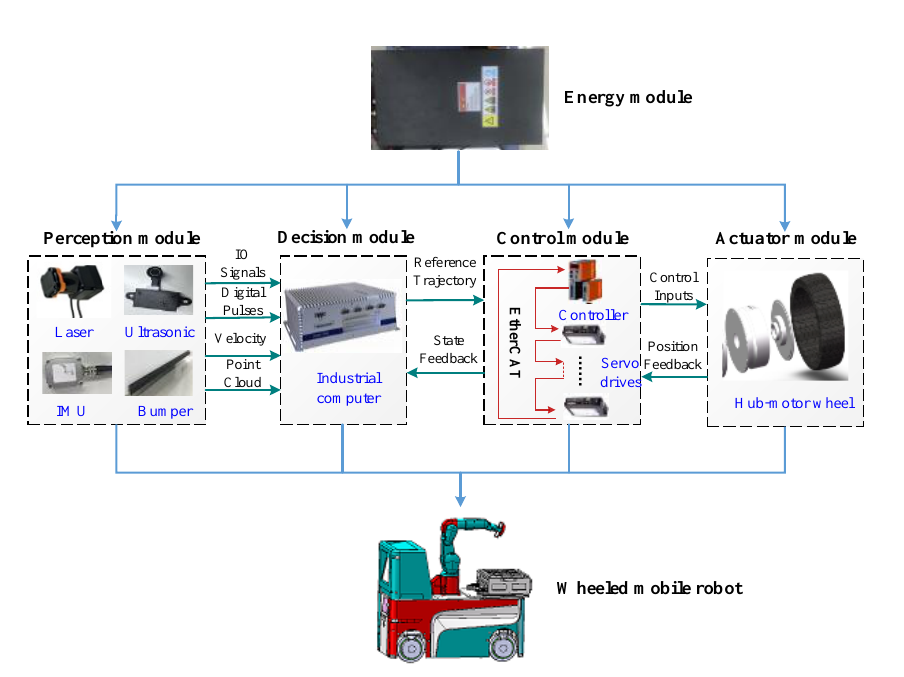
Figure 1. Hardware architecture.